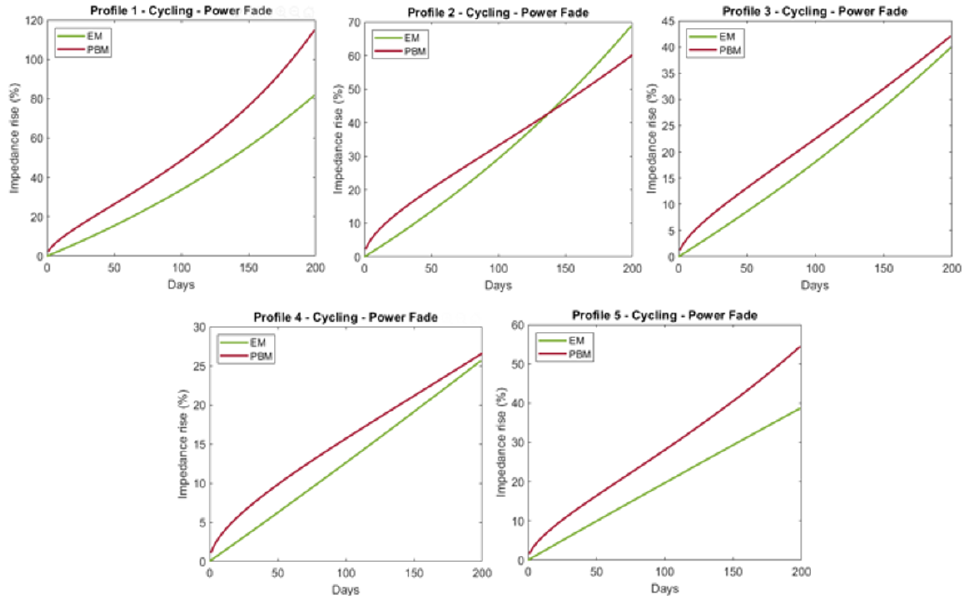
Figure 7. Comparison of resistance increase in cycling aging between EM and PBM. The cycling conditions are identified by the profile number in Figure